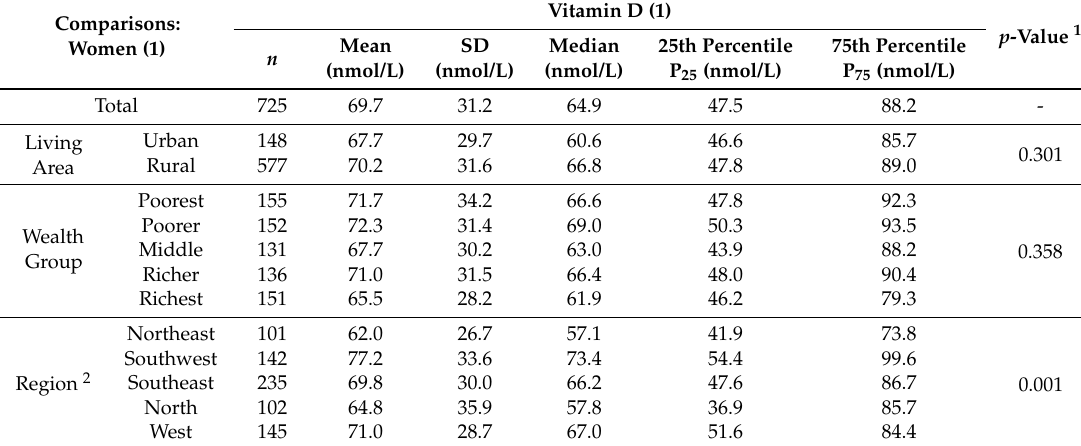
Table 1. Comparison of relationships between vitamin D concentration status and living area (urban/rural), wealth grouping, and geographic region, among